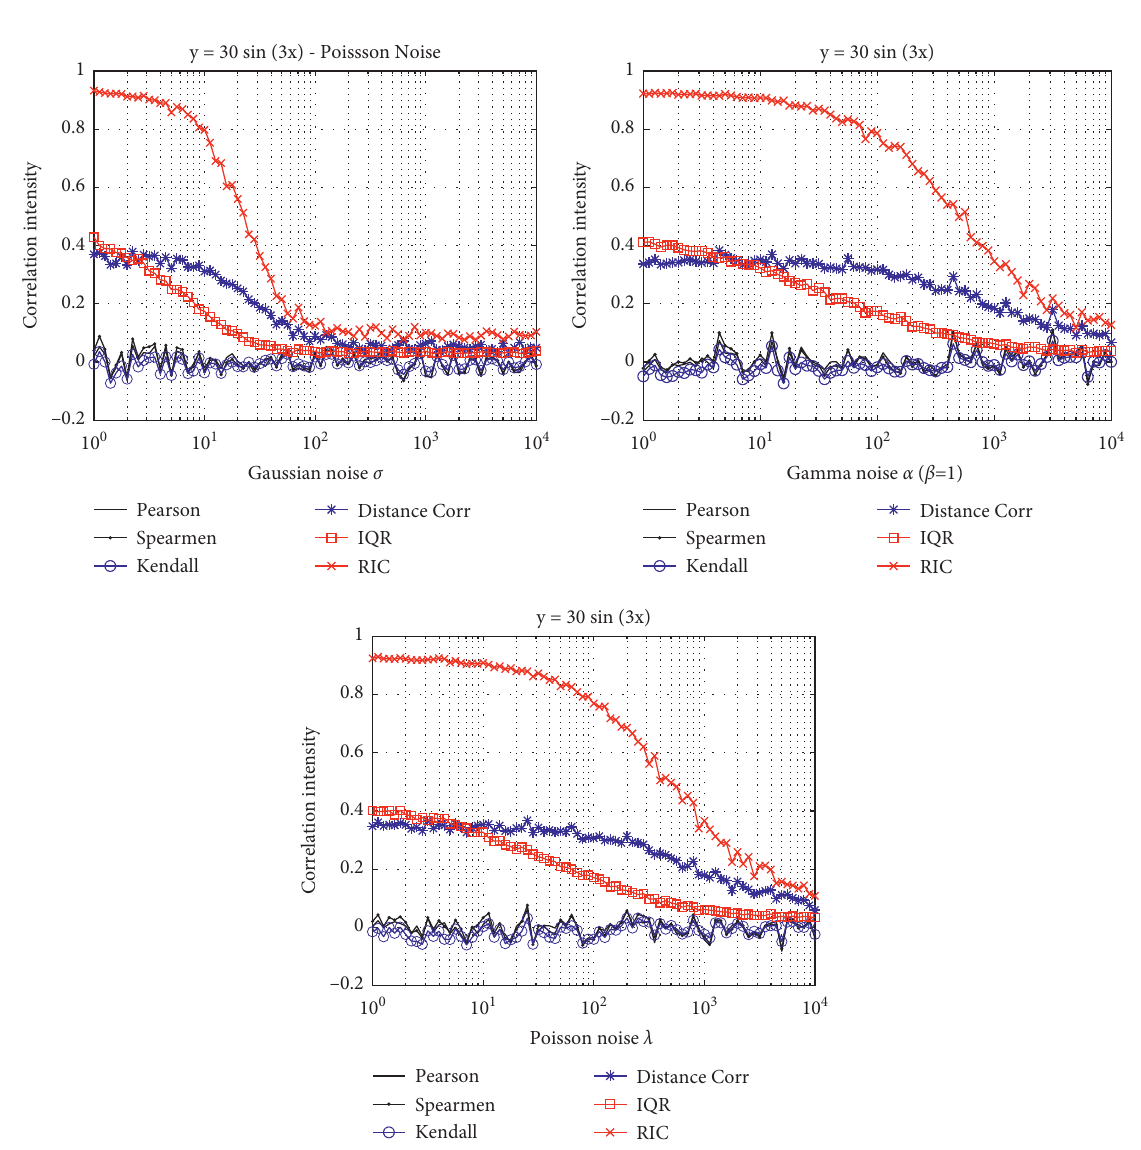
Figure 5: Comparison of RIC and the other criteria for nonlinear correlations, y � 30 sin (3 x ), in which the signals are affected by additive noise of different